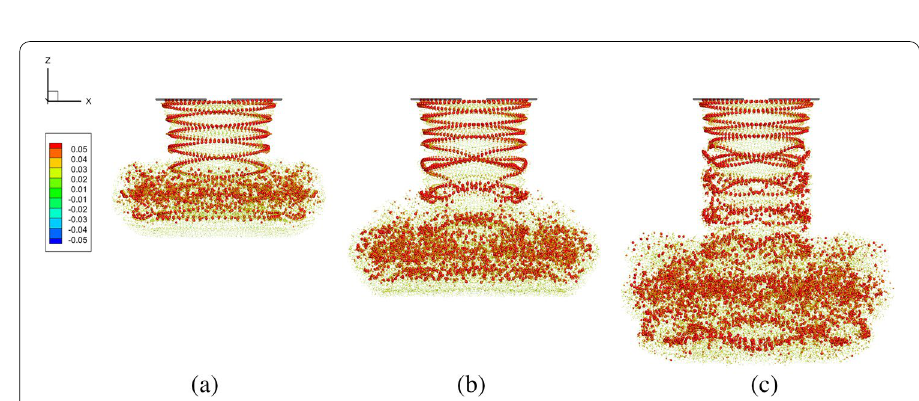
Fig. 7 Rotor wake structures: ( a ) 10 rev., ( b ) 15 rev., and ( c ) 20